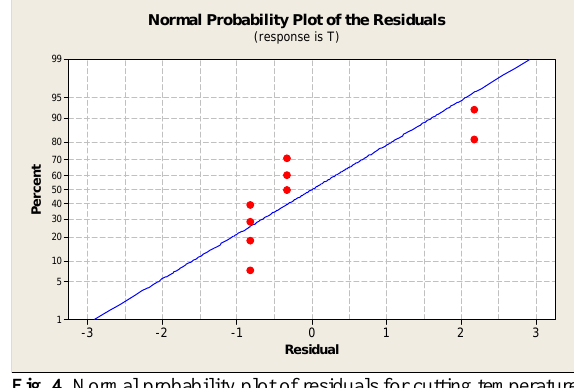
Fig. 1. Anderson Darling test for normality for cutting force (F)